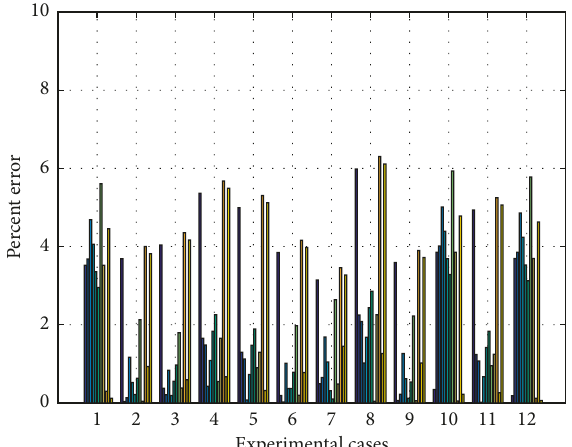
Figure 7: VIV occurrence velocity prediction error for all 12 cases.